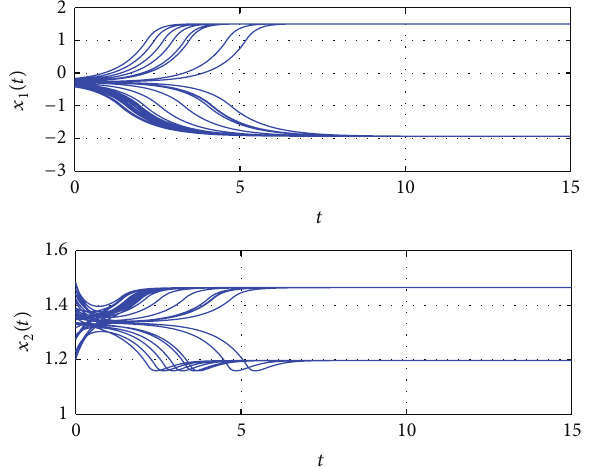
Figure 12: Transient behavior of 𝑥 1 in Example 2.